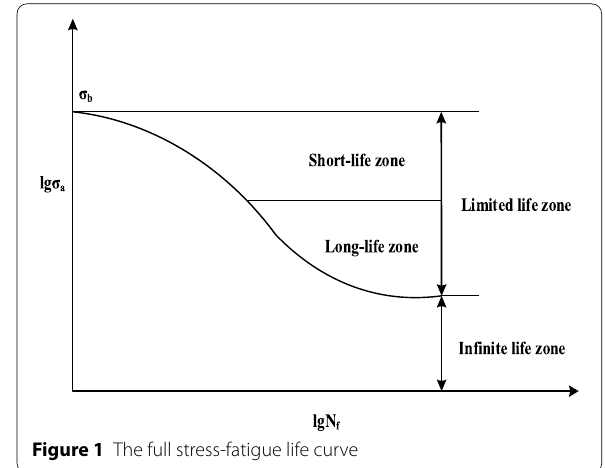
Figure 1 The full stress‑fatigue life curve